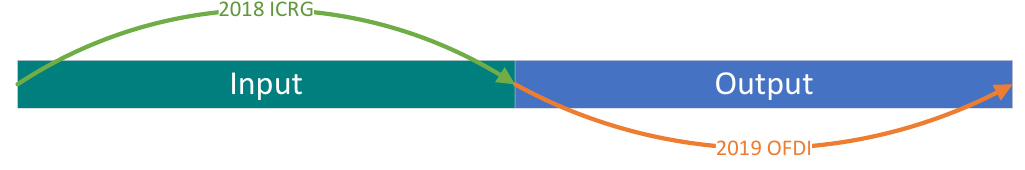
Figure 3. Schematic diagram of model input and output.